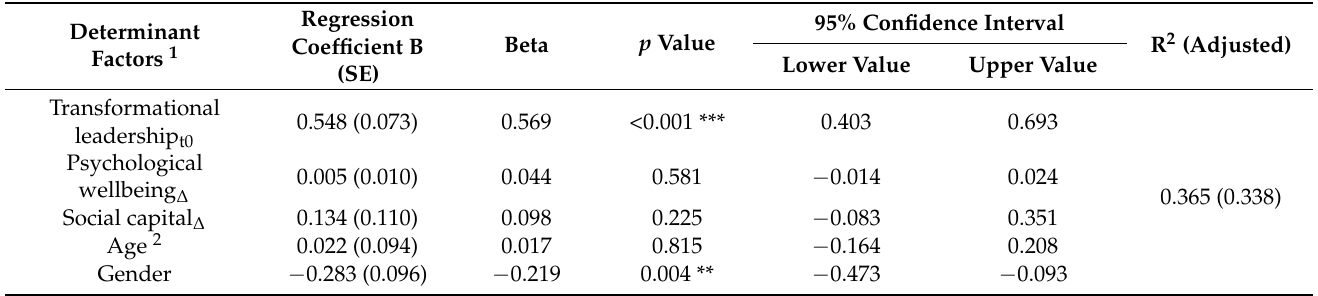
Table 4. Multiple linear regression analysis, model I.